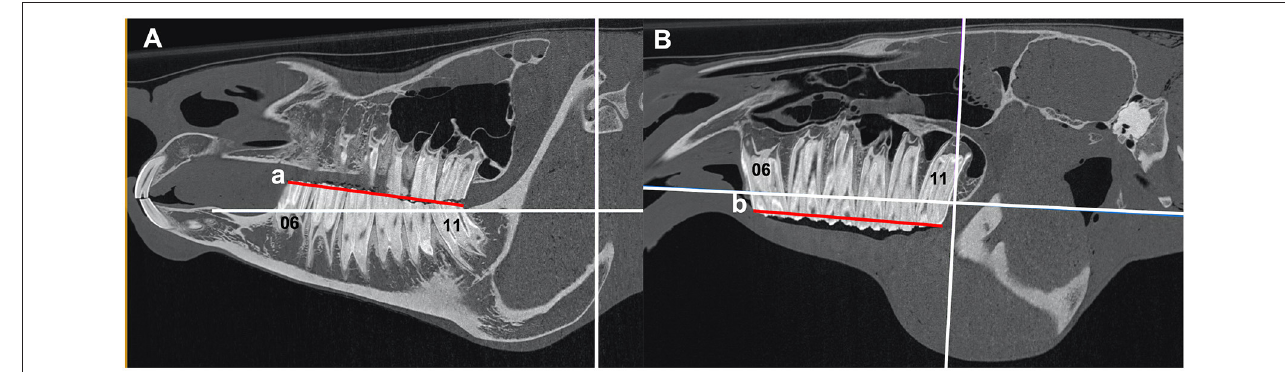
FIGURE 1 | (A,B) Sagittal CT images of an equine head showing the length (red lines) of the mandibular (a) and maxillary (b) arcades measured at the occlusal surface from the mesial aspect of 06 to the distal aspect of 11. The red line “a” and “b” shows the length of the mandibular and maxillary arcade, respectively.